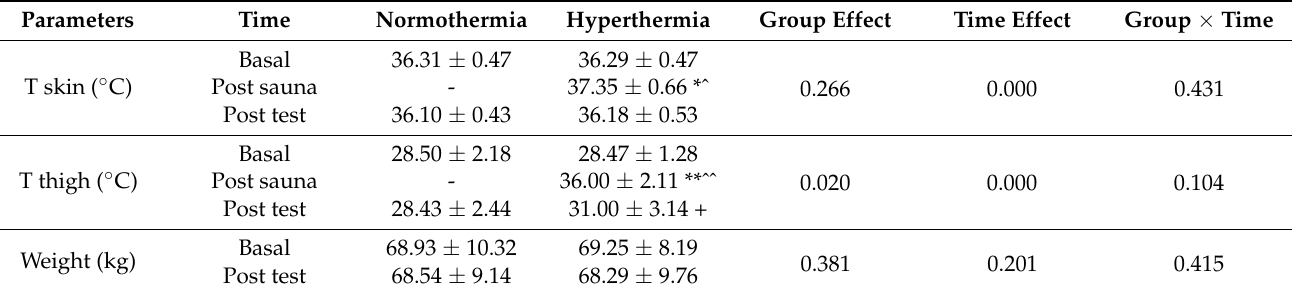
Table 4. Changes in body weight and body temperatures in the different evaluations.